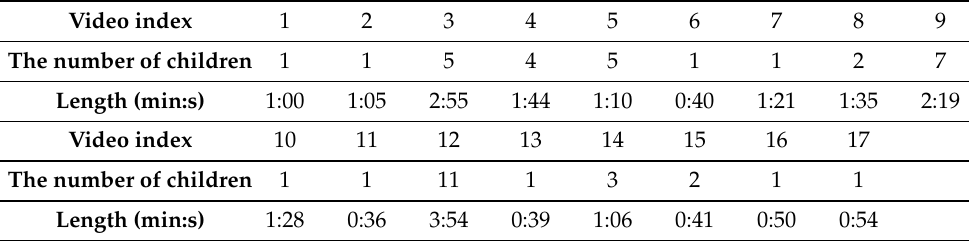
Table 8. Videos used in the child face recognition experiment.